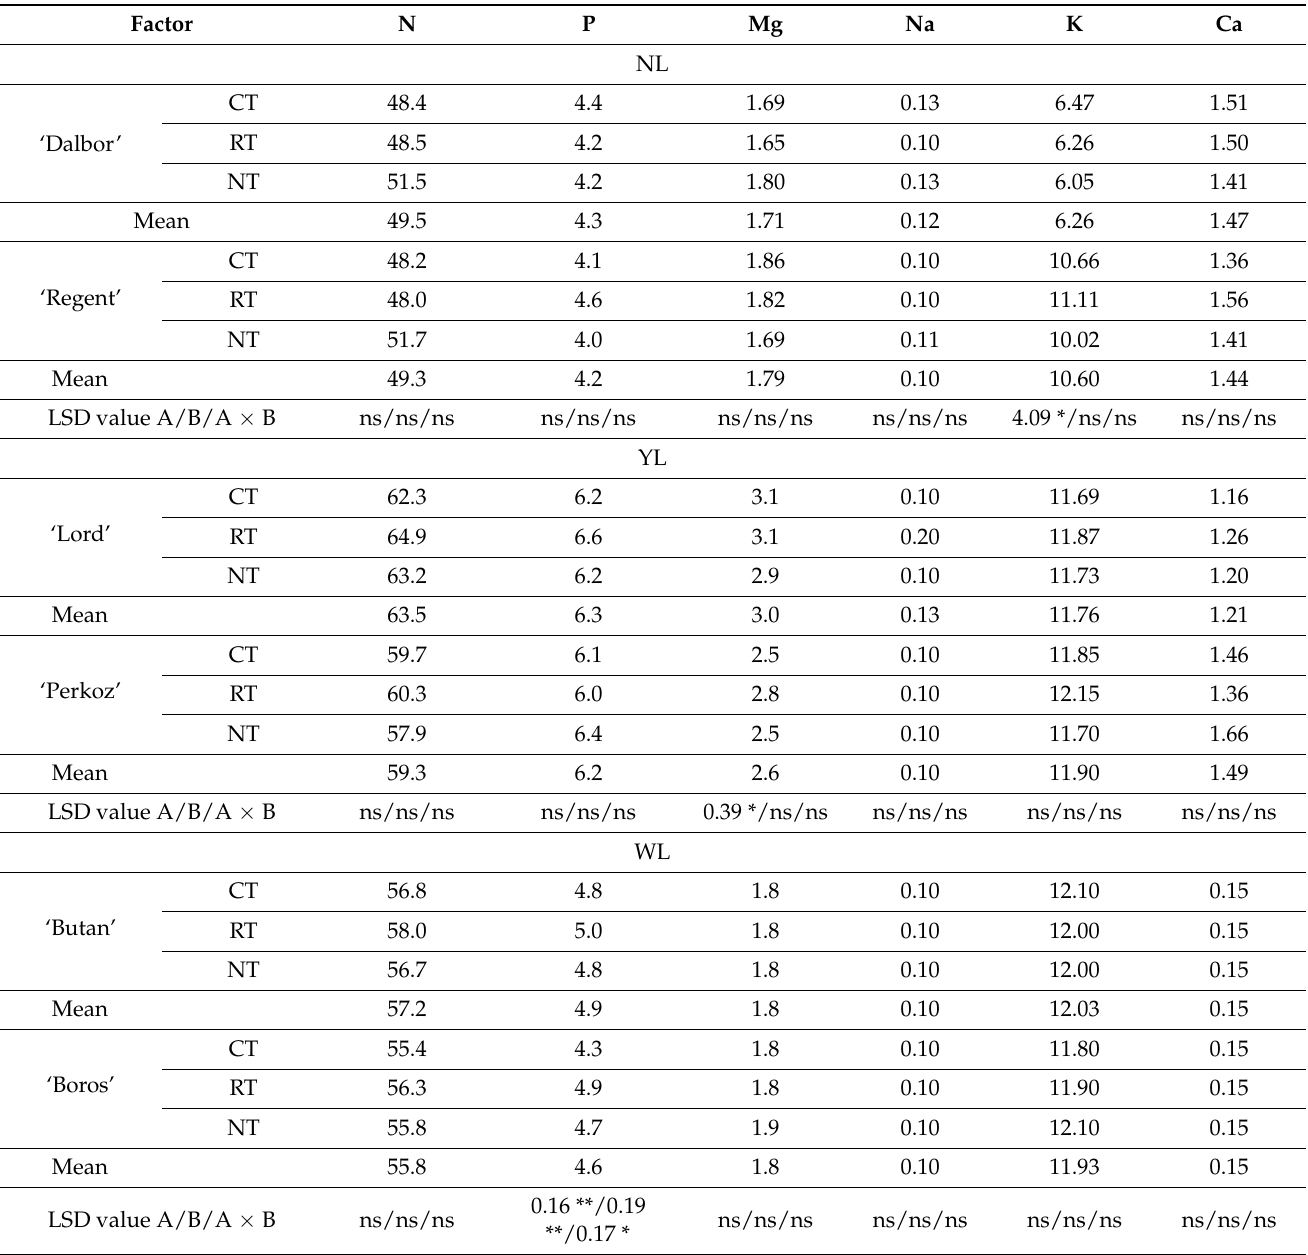
Table 3. Macroelements (mg g − 1 dry mass) in lupin